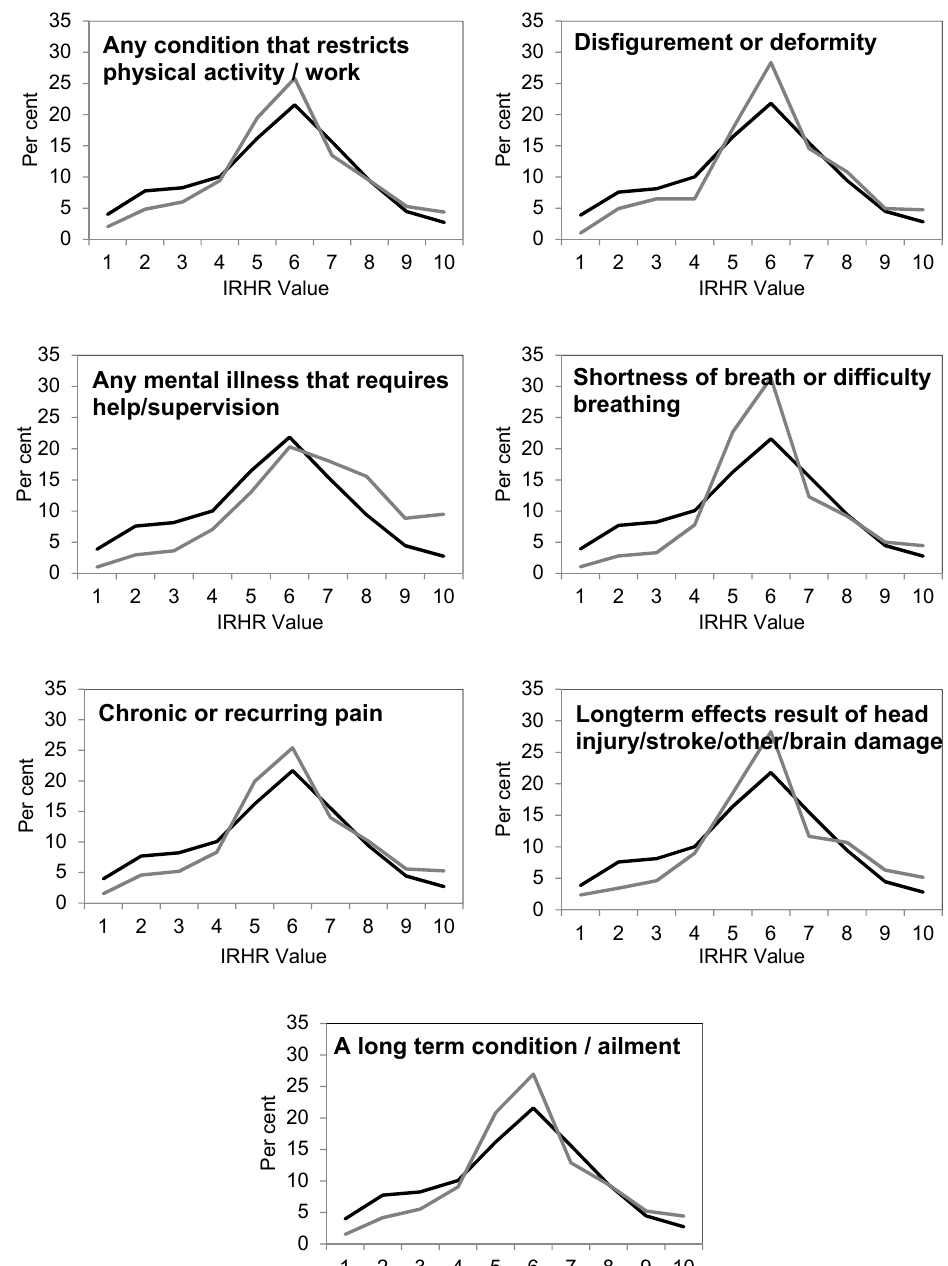
Figure 3. Index of relative homelessness risk by presence (light grey line) and absence (black line) of selected disability types (data source: [26]).